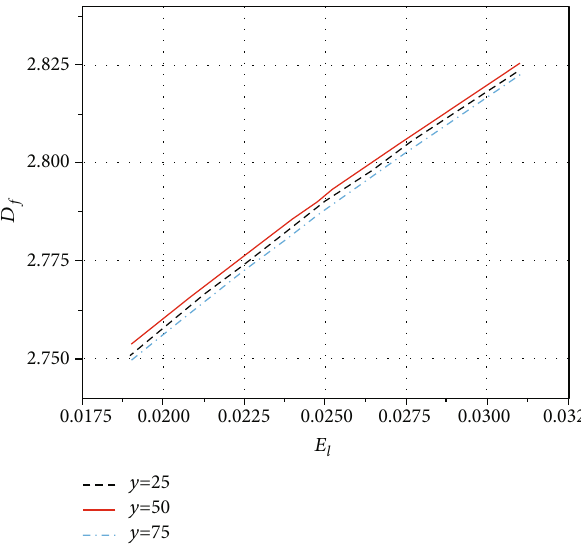
Figure 12: In fl uence of Langmuir volume strain constant ε fractal dimension D of fracture f